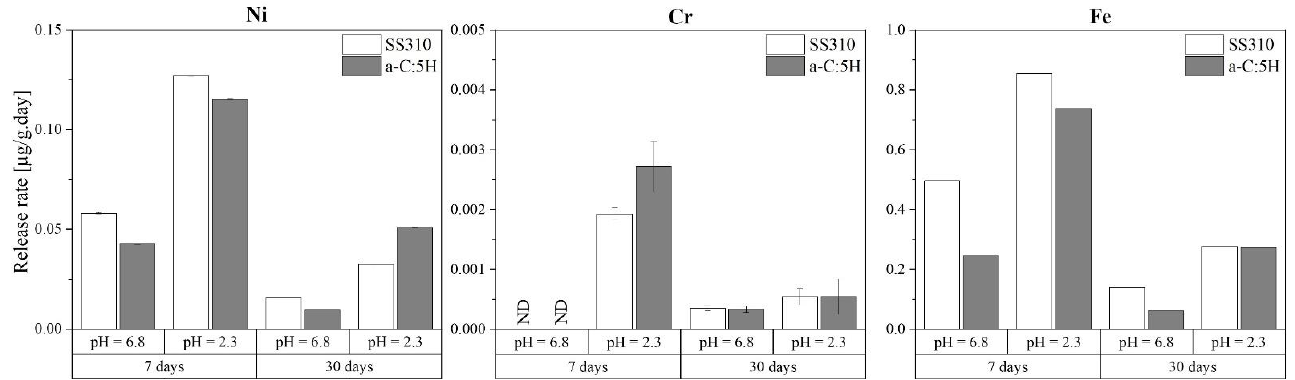
Figure 8. Average release rates of Ni, Cr, and Fe of SS310 and a-C:5H samples. ND: not detected. After the 30-day immersion corrosion test in the artificial saliva with pH = 2.3, SEM surface analysis revealed pitting corrosion on the SS310 uncoated samples (Figure 9), which were absent at pH = 6.8. Indeed, SS, as all Fe alloys, is known to be susceptible to pitting corrosion, especially in chloride-containing solutions [43,72,73]. This is a localized metal dissolution reaction, which is nucleated at the external passive film by the presence of defects such as crevices, pores, inclusions, etc. The reaction progress requires that the environment inside the pit be able to maintain the continuous active dissolution state at the pitting surface. Two main constitutes, H + and Cl − , are involved: H + is derived from the hydrolysis of metal cations, and Cl − (in solution) migrates into the pit to balance the charge and maintain the